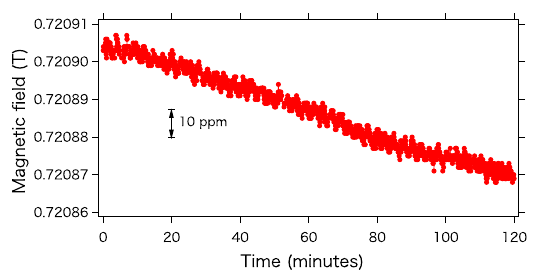
FIG. 3. Stability of the kicker magnetic fields. The kicker runs at 60 Hz and the sampling interval of the pulsed magnetic fields is 3 seconds.